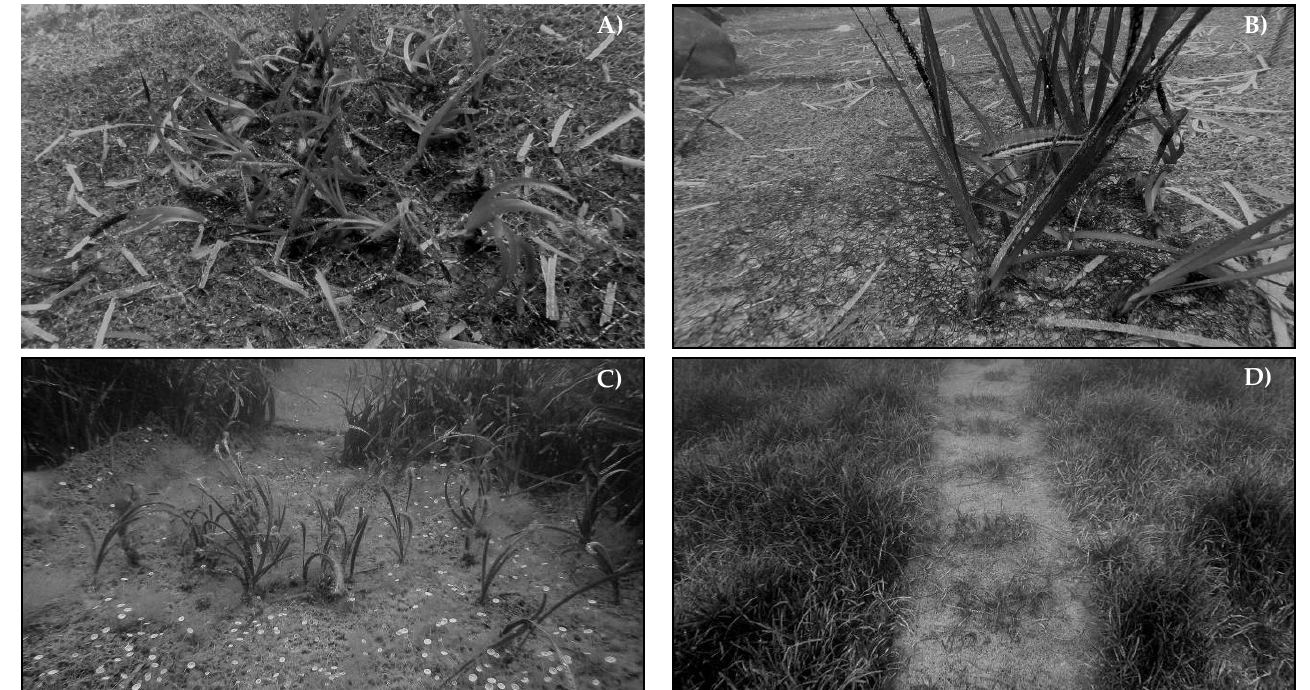
Figure 6. Arrangement of transplanting plots at Capo Carbonara ( A ) and at Elba Island ( B ).